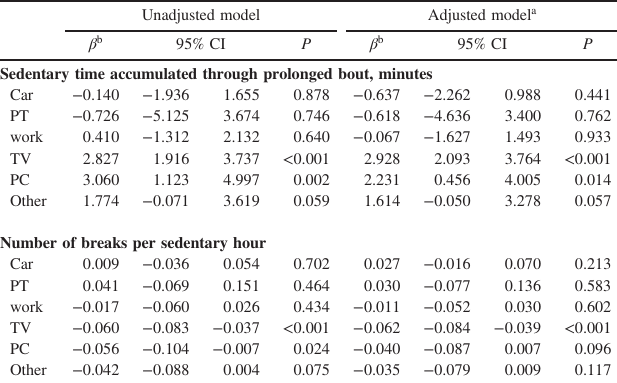
Table 3. Relative contributions of sedentary domains to objec- tively-measured sedentary